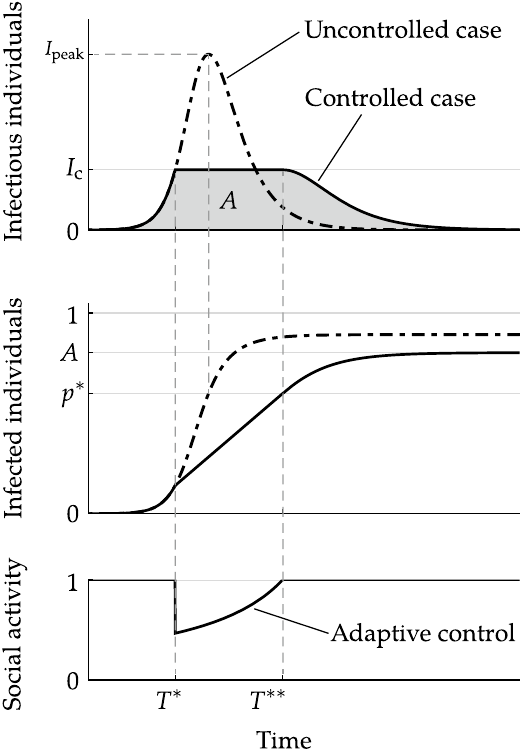
Figure 1. Proposed adaptive control measure. The top and middle shows the number of infectious individuals I ( t ) and infected (infectious or recovered) individuals, respectively, 1 − S ( t ) at time t . An uncontrolled case is indicated using the dot-dashed curve, whereas a controlled case is indicated using the black solid curve. An adaptive control that reduces social activity as in the bottom panel is imposed at T ∗ and lifted when herd immunity in this group is established at T ∗∗ . The area of the gray region below the controlled curve in the top panel presents the final number of infected individuals in the active group, A . As the number of infectious individuals start to decrease at T ∗∗ , A will exceed p ∗ = 1 − R − 1 0